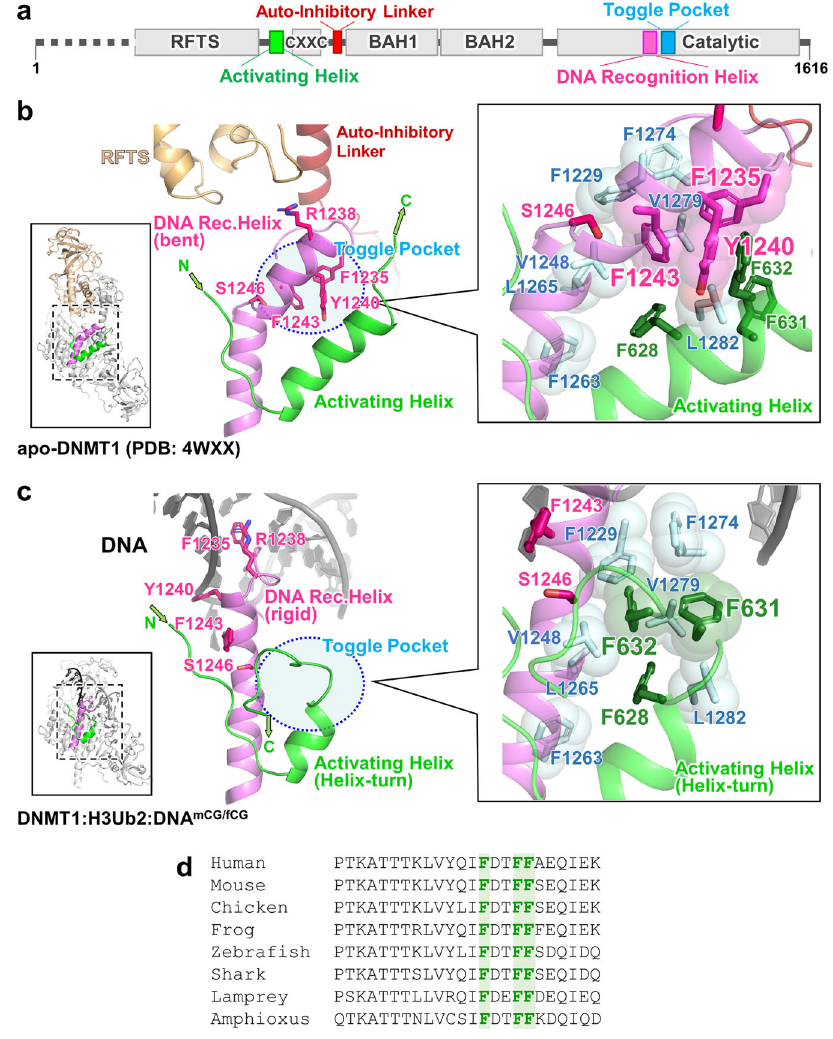
Fig. 3 | Activation of DNMT1 by a pair of phenylalanine residues in the Acti- vating Helix. a Domain structure of DNMT1. b Structure around Activating Helix (green), DNA Recognition Helix (pink), and Toggle Pocket (pale cyan) of apo- DNMT1 (PDB:4WXX). The Toggle Pocket is highlighted by a light blue circle. The right panel is a magni fi ed fi gure of the Toggle Pocket. Residues in Activating Helix and DNA Recognition Helix that are involved in binding to the Toggle Pocket are